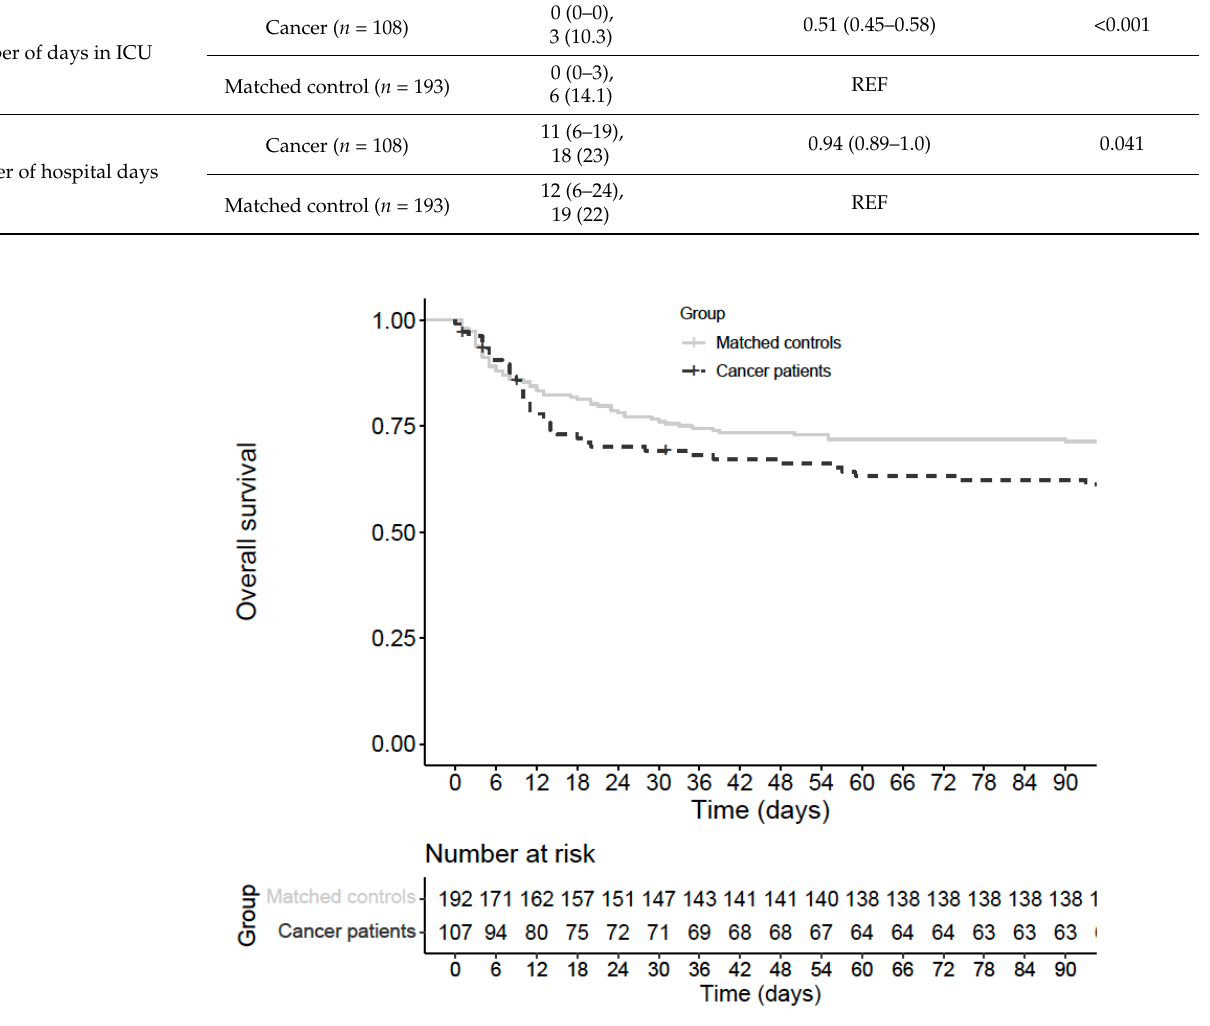
Figure 1. Overall survival from hospital admission among cancer patients and matched controls.